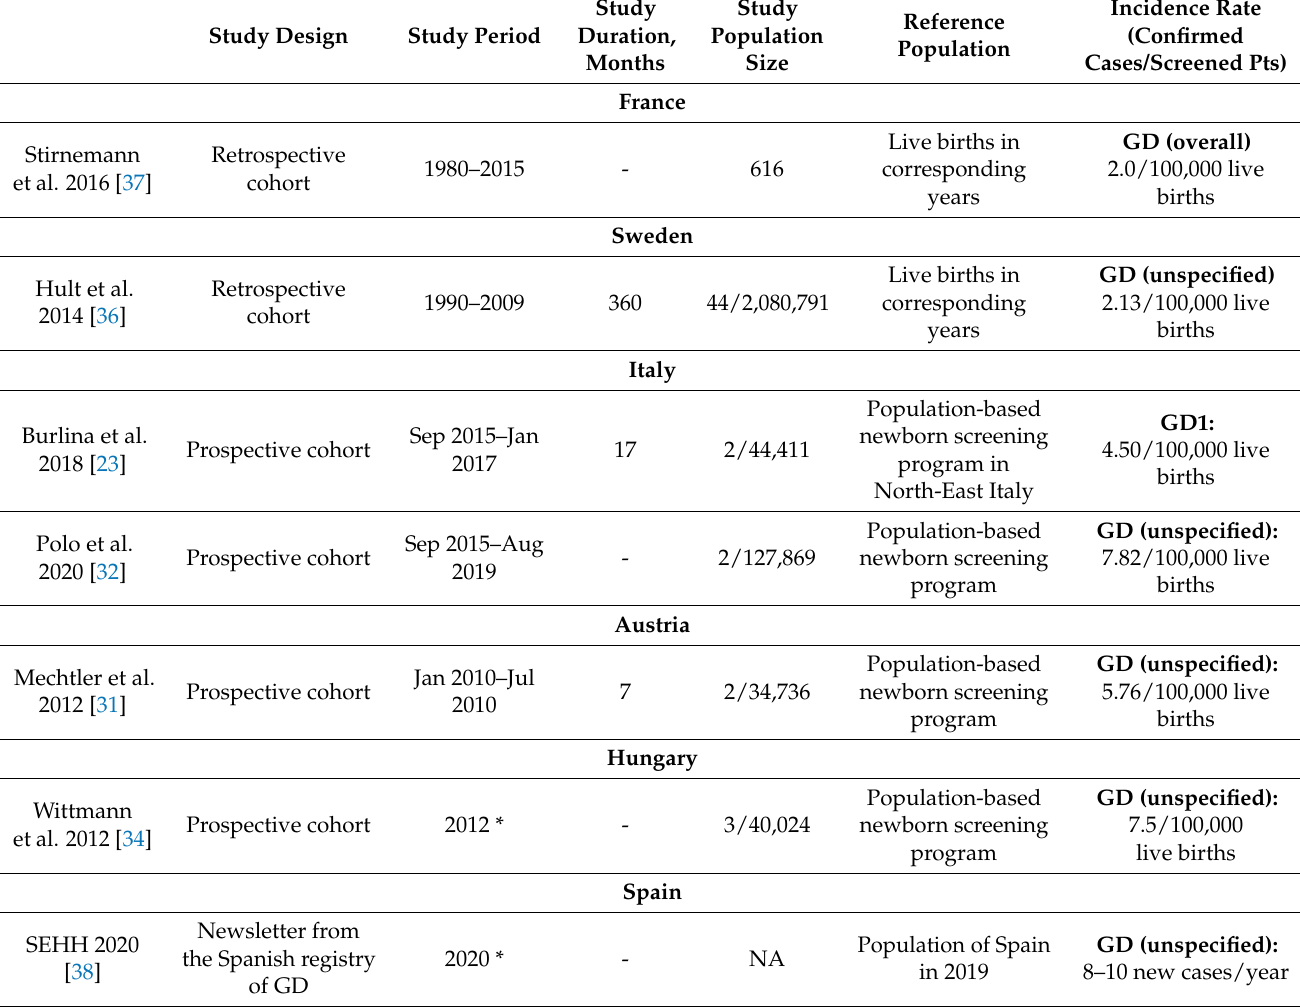
Table 3. GD incidence: